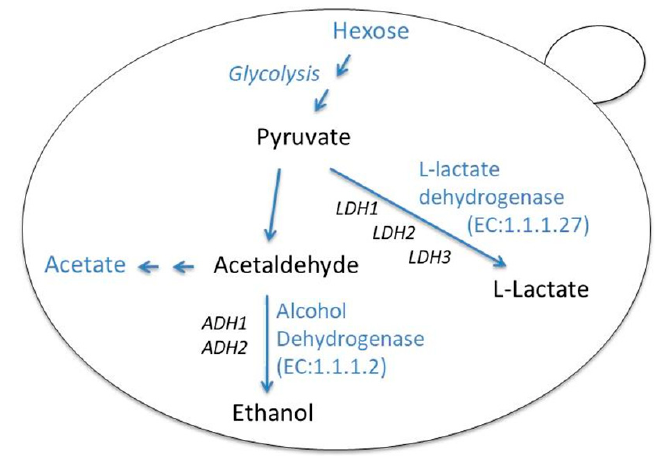
Figure 7. Simplified schematic representation of fermentative sugar metabolism in L. thermotolerans based on KEGG (Kyoto Encyclopedia of Genes and Genomes) Pathway Database; https://www.genome.jp/dbget-bin/www_bget?lth00010. Pyruvate can be directly converted into lactate through the action of L-lactate dehydrogenase (LDH) or into ethanol by alcohol dehydrogenase (ADH). In the genome of L. thermotolerans there are 3 paralogs encoding LDH and 2 ADH paralogous genes.